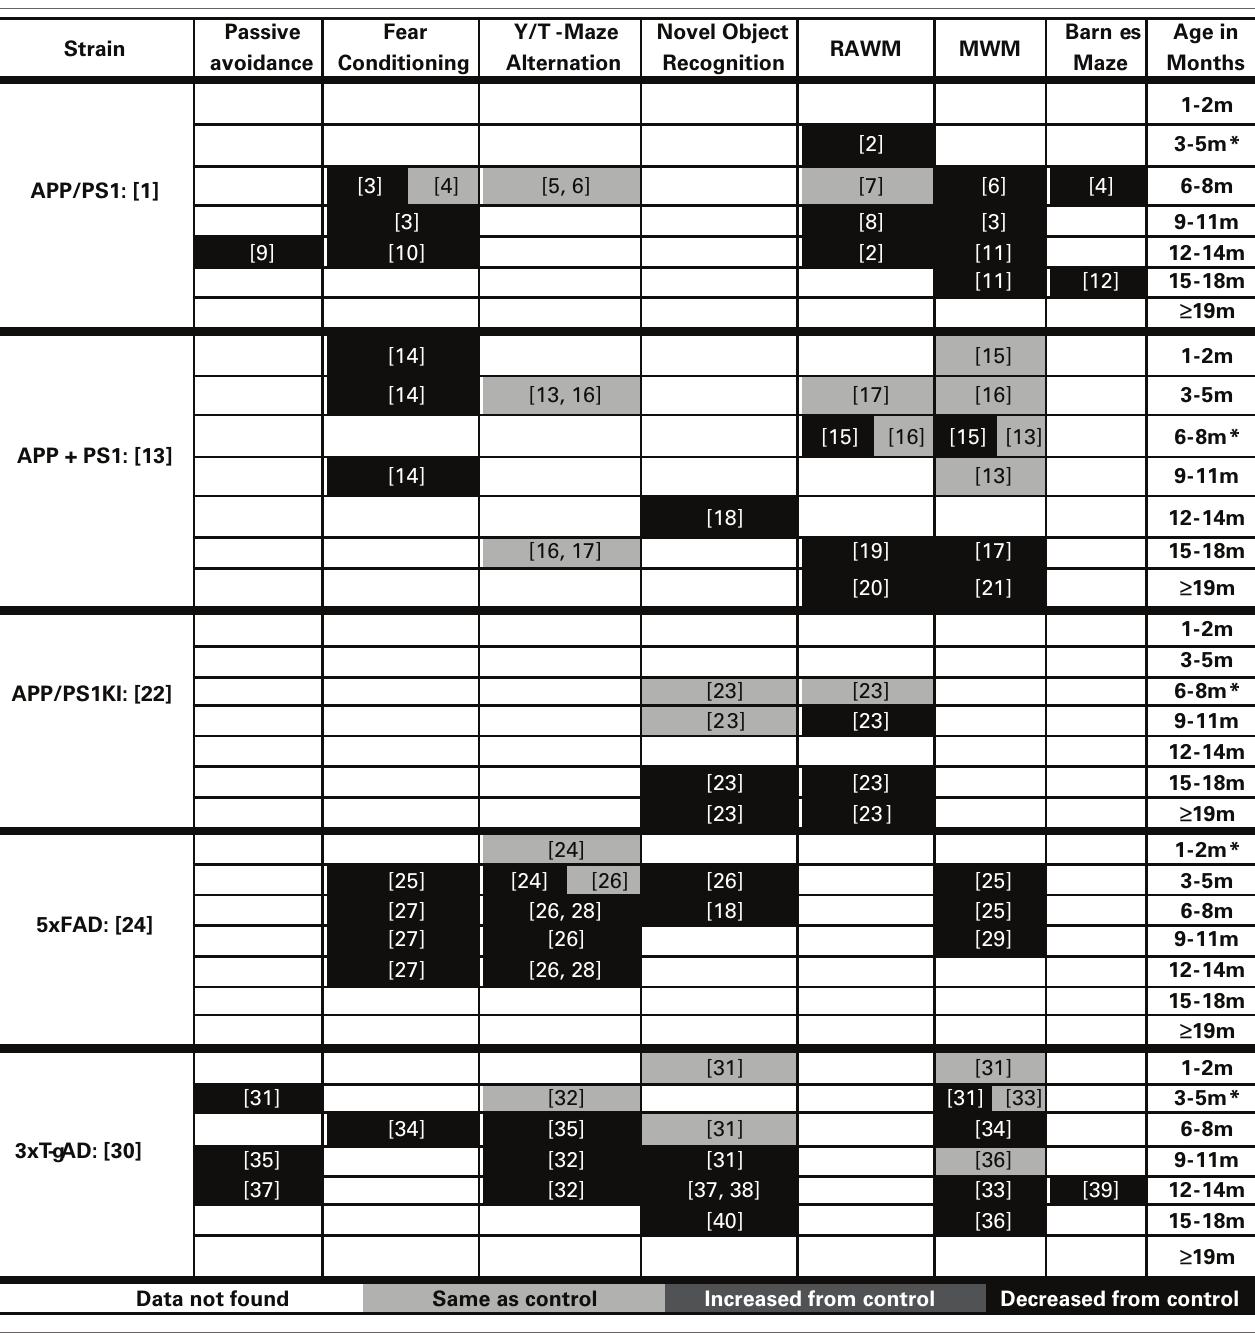
Table 4 | Progression of memory deficits in other mouse models of AD (APP +